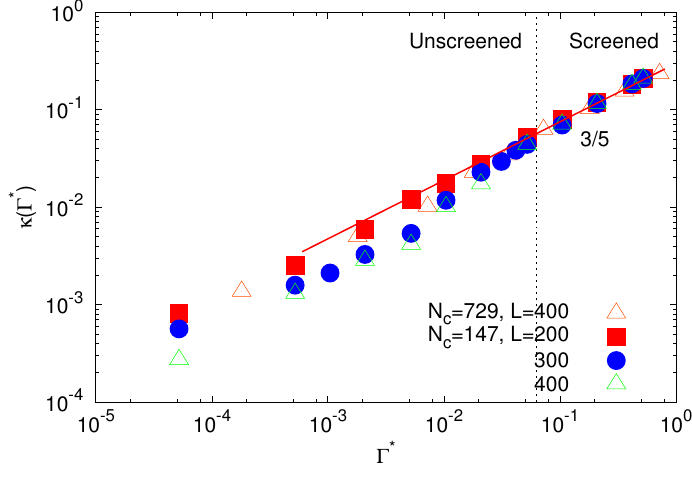
Figure 4. Inverse Debye screening length as a function of the scaled interaction strength for microgels with N c = 147 and 729 crosslinks. For the larger microgel, the size of the simulation box is L / l = 400, and for the smaller one with N c = 147, the boxes are L / l = 200, 300 and